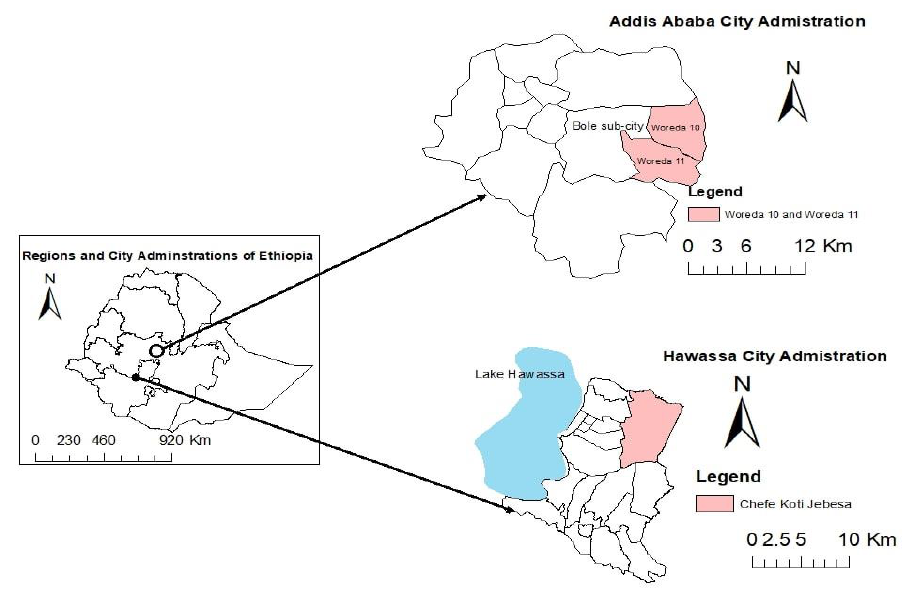
Figure 1. Map of study sites, Addis Ababa and Hawassa.